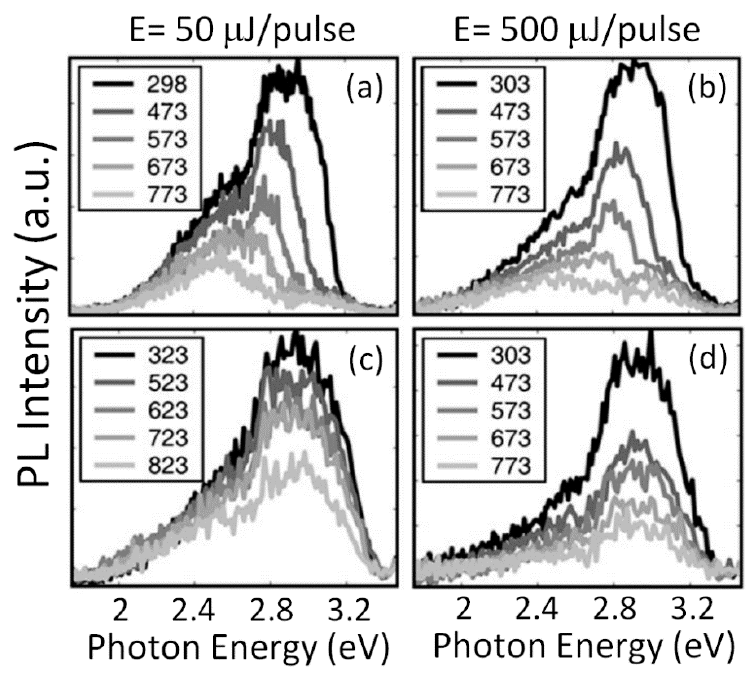
Figure 5. PL emission spectra (a.u. stands for “arbitrary units”) at different temperatures (see label, in Kelvin degrees) and different pump energies (50 µ J/pulse (left column) and 500 µ J/pulse (right column)); ( a , b ) refer to pure STO and ( c , d ) to an Nb-doped STO samples. This figure has been reprinted from [30], Copyright (2009), with permission from Elsevier.